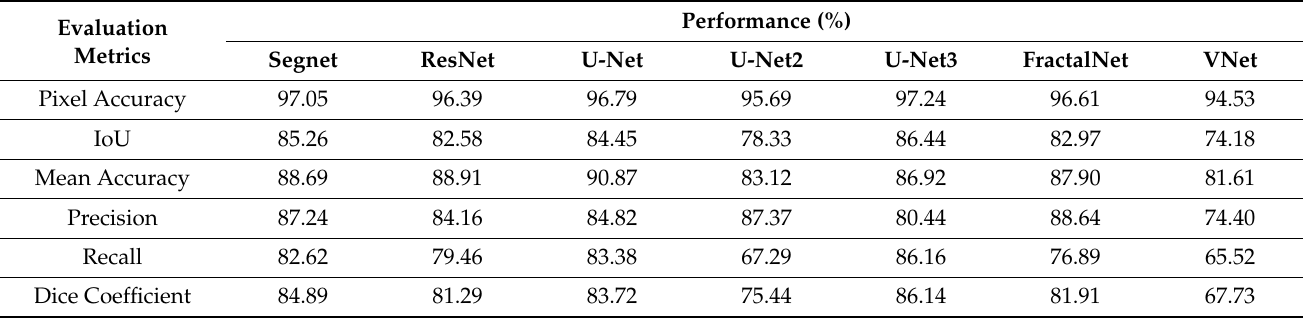
Table 6. Performance measurement with unseen